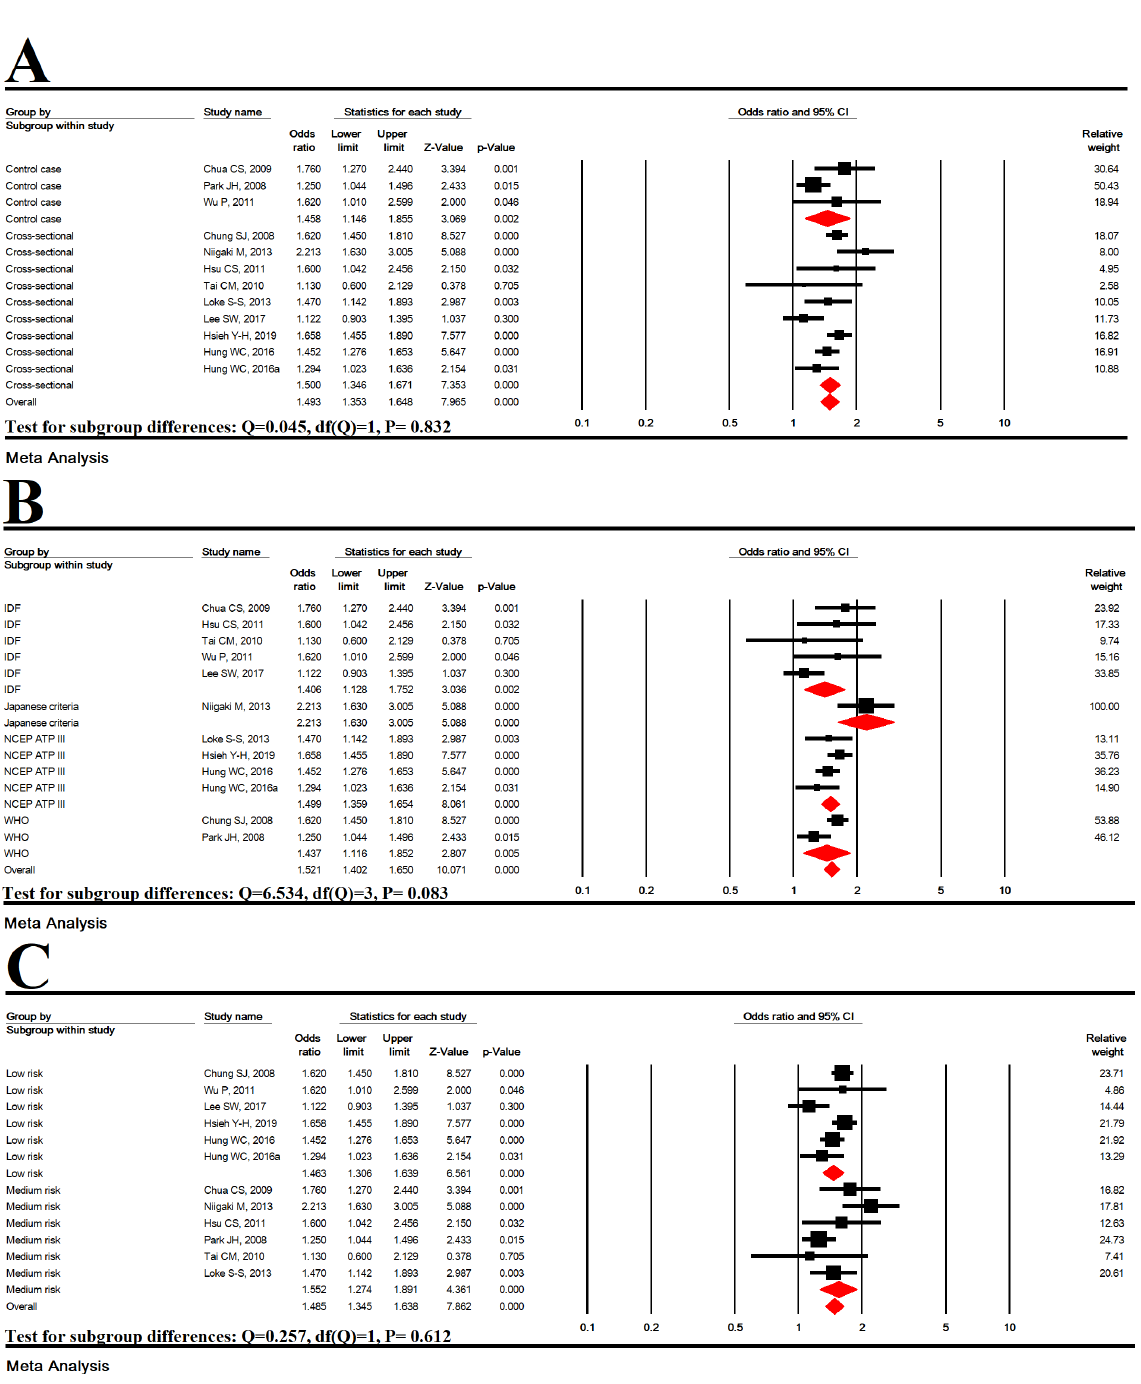
Figure 4: Subgroup analysis based on study type ( A ), MetS diagnostic criteria ( B ) and studies quality ( C